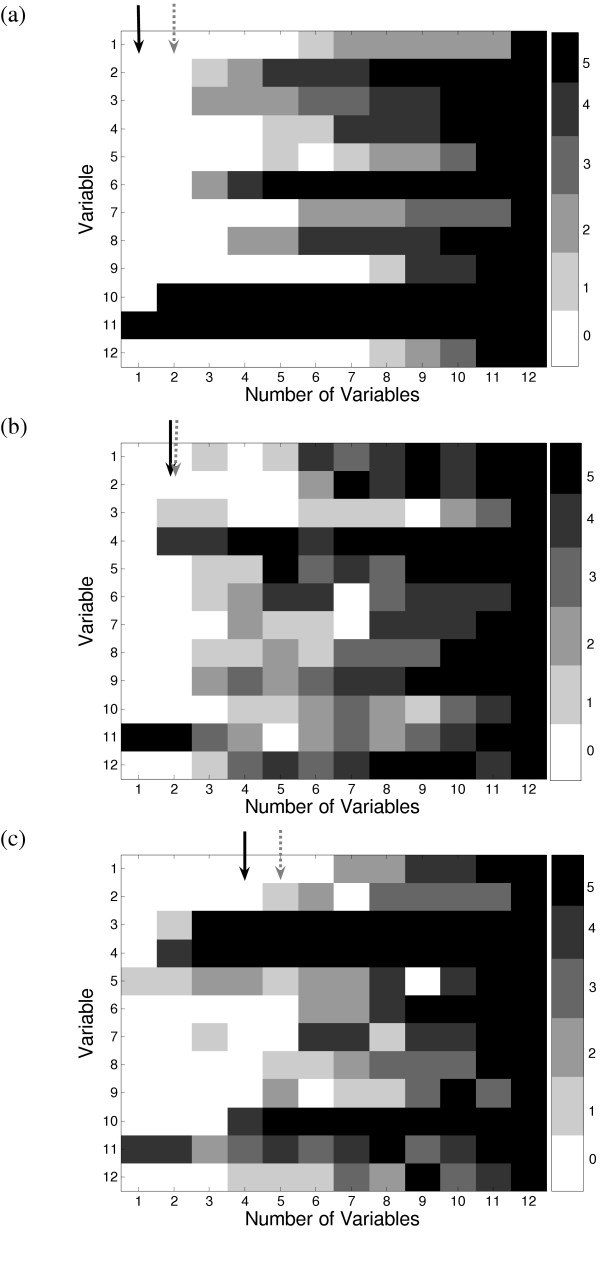
Variables selected in five fold cross-validation (CV) for the models. Variables (X1 to X12) are plotted versus model subset size (p). Counts of the selected variables in five-fold cross-validation for (a) multiple linear regressions (MLRs), (b) regression trees (RTs), and (c) artificial neural networks (ANNs) as subset size, p, increases from 1 to 12 along x-axis. The darker the color the more often a variable (y-axis) was selected for a model with a given number of independent variables (x-axis). Light-dotted and dark-solid arrows indicate the models with minimum errors and the most parsimonious models within one standard error of the minimum, respectively, as in Figure 2.